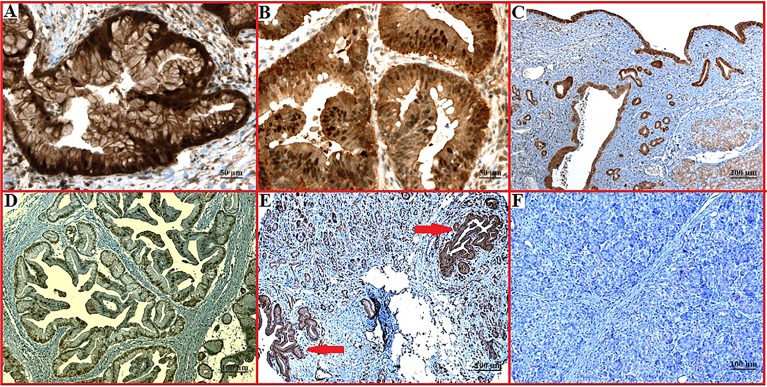
LDHA expression pattern in pancreatic cancer, benign and normal tissue sections.(A) Membranous expression of LDHA (x200 magnification). (B) Cytoplasmic and nuclear expression (x200 magnification). (C) Strong expression in pancreatic cyst with mild expression in the surrounding normal pancreatic tissue (x50 magnification). (D) Nuclear expression of LDHA in pancreatic cancer (x100 magnification). (E) Strong expression in PanIN lesion (x100 magnification). (F) Negative staining in normal pancreas (x100 magnification).